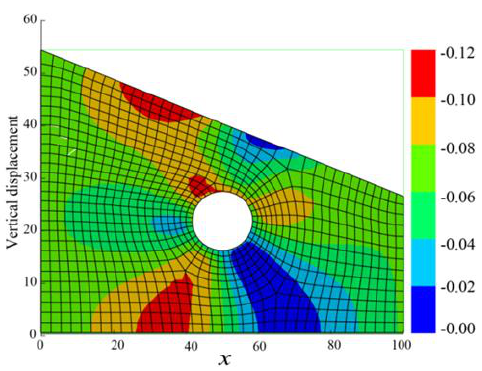
Figure 21. Numerical representation of the meshes around a tunnel beneath an inclined plane.